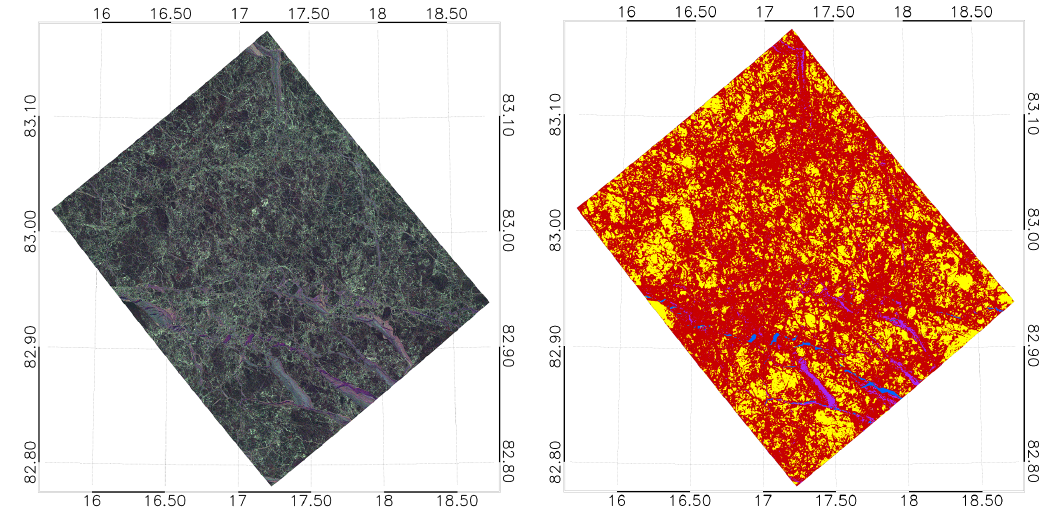
Figure A10. ( Left ) Geocoded Pauli RGB composite (Red: HH-VV Green: HV+VH Blue: HH+VV) of the RS-2 acquisition on 23 April 2015, frame 2; ( Right ) ice classification. Blue: open water/nilas (OW), purple: young ice (YI), yellow: first year ice (SFYI), red: rough first year ice/multi-year ice